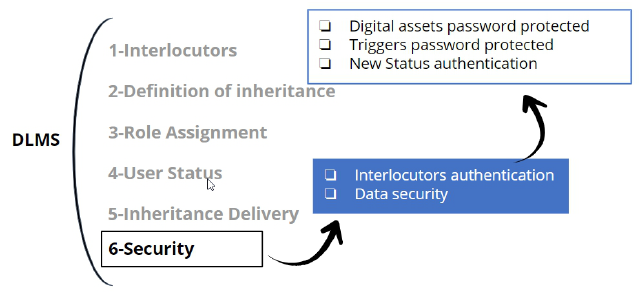
Fig. 7. Security Mechanisms in DiLeMa Framework.